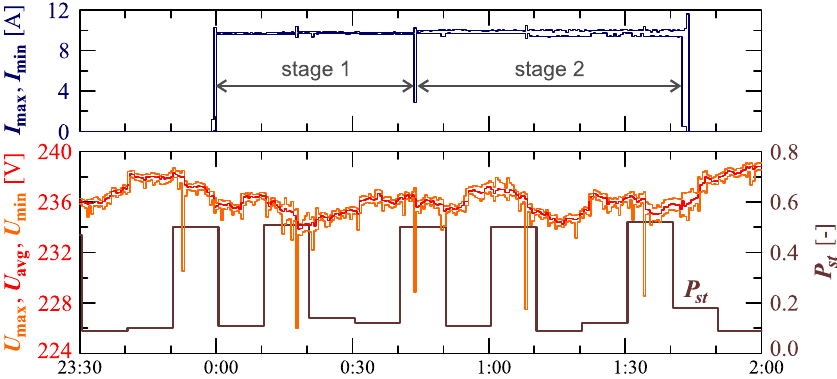
Figure 3. The characteristics of maximum U max = f ( t ) , average U avg = f ( t ) and minimum U min = f ( t ) values of rms values of supply voltage and characteristic P st = f ( t ) for Case